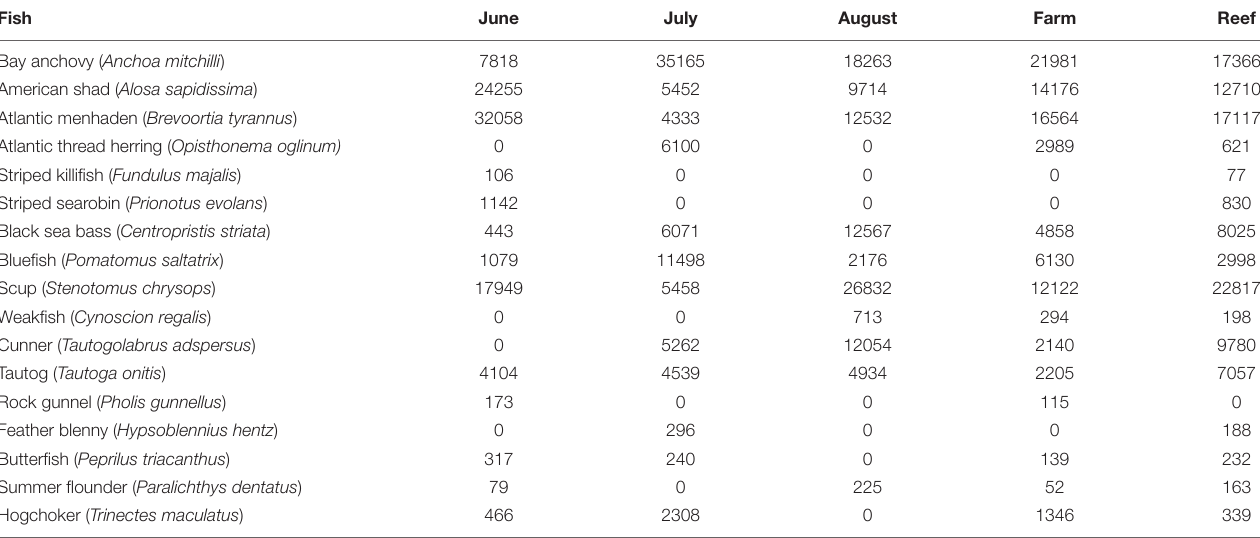
TABLE 1 | Major finfish taxa and their average sequence abundance per month (8, 7, and 8 samples for June, July, and August, respectively) and per site (12 and 11 samples at Farm and Reef, respectively).